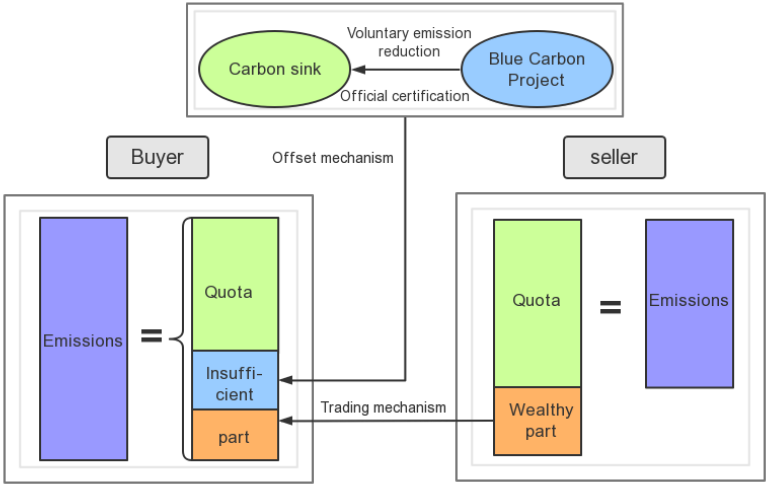
Figure 2. The transaction flow process of buyers and sellers. (Source: Collated from [49]).